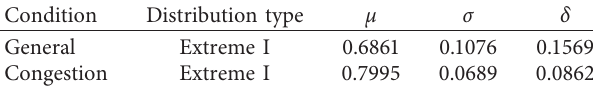
Table 1: Dimensionless parameter KSQ